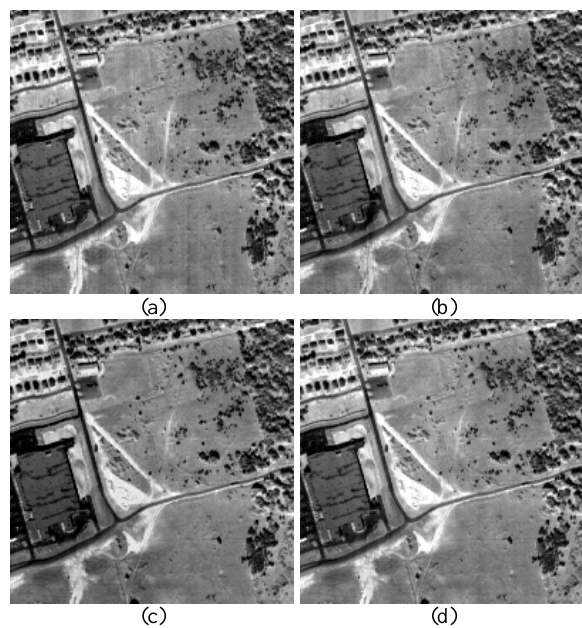
Fig 4. Destriping results of Terra MODIS band 27: (a) MM;